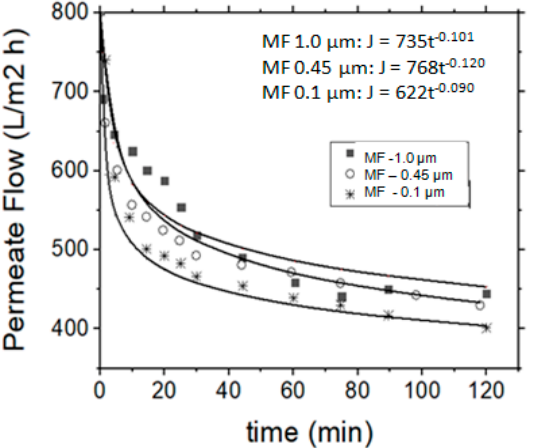
Figure 3. Permeate flow rate variation (or flux) vs. operation time, regarding the application of MF process for the treatment of simulated tannery wastewaters.